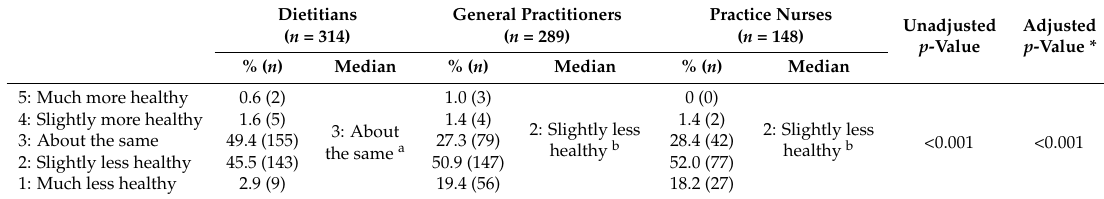
Table 7. Perceived healthiness of peanuts in comparison to tree nuts as rated by health professionals.